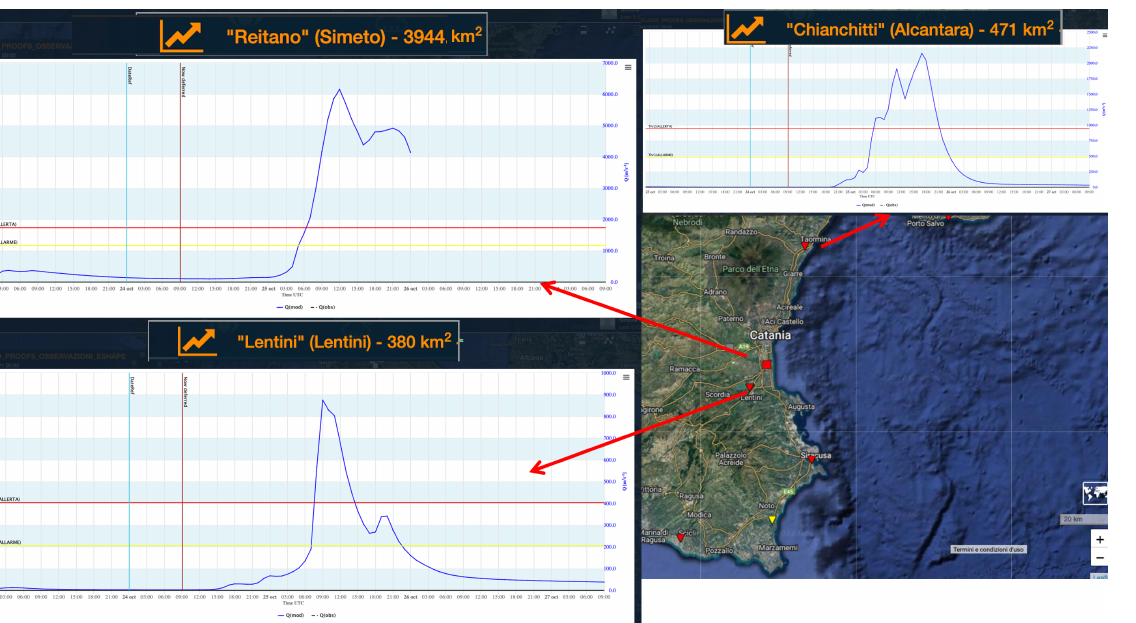
Figure 15. OCTOBER 24 09 UTC: Flood-PROOFS stream flow deterministic forecast using WRF-DA of the 24 October at 00 UTC as